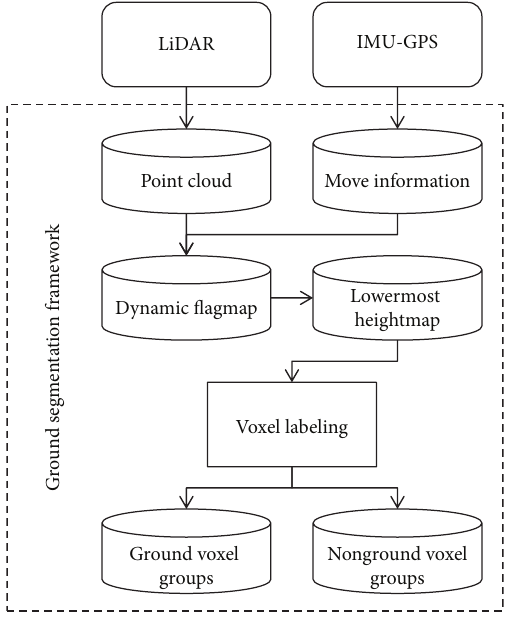
Figure 1: Overview of the ground segmentation